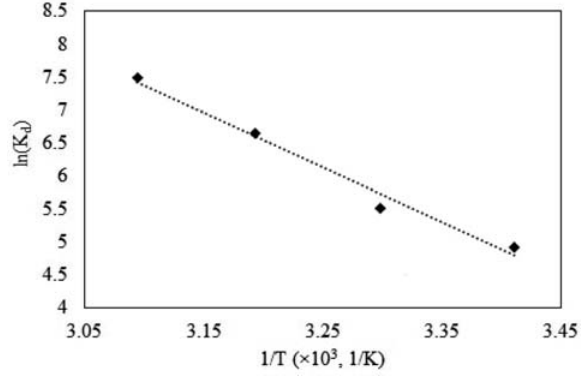
versus 1 / T for Cr(III) adsorption by borax slud- d